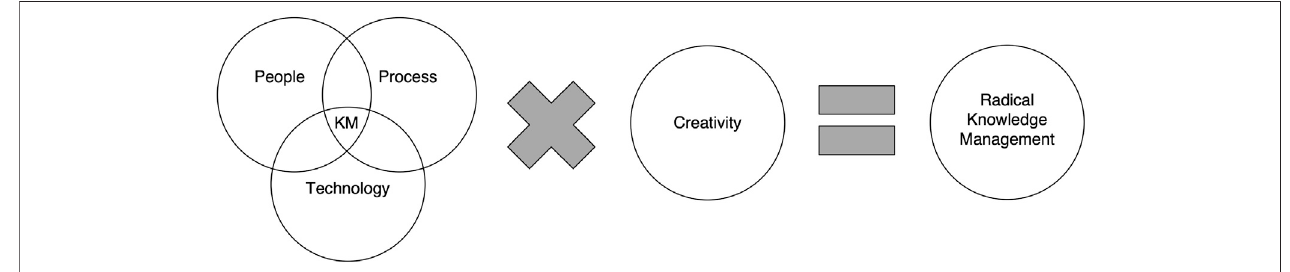
FIGURE 1 | Radical knowledge management.